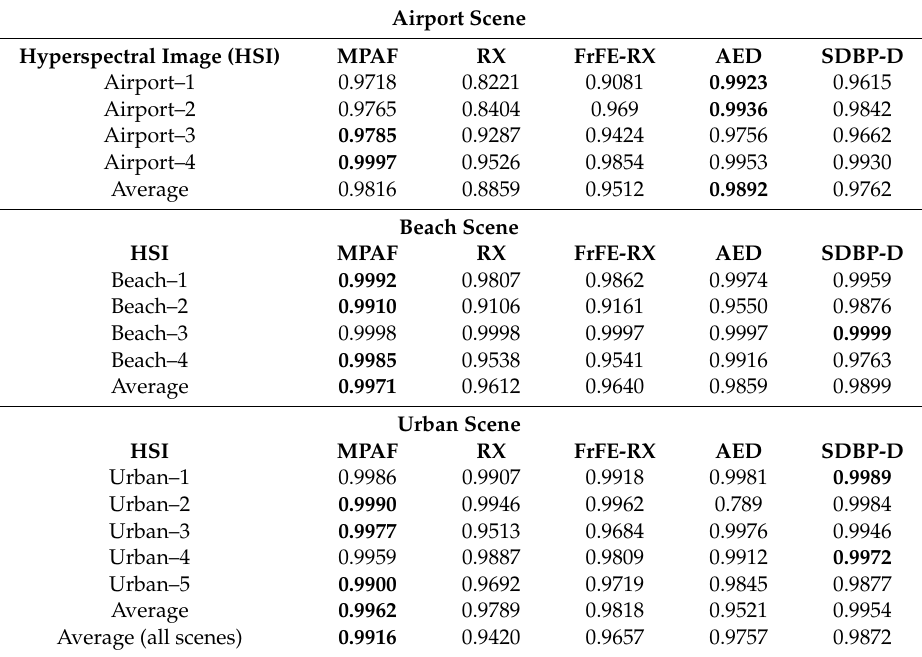
Bold numbers are used to highlight which score is the best among others in a